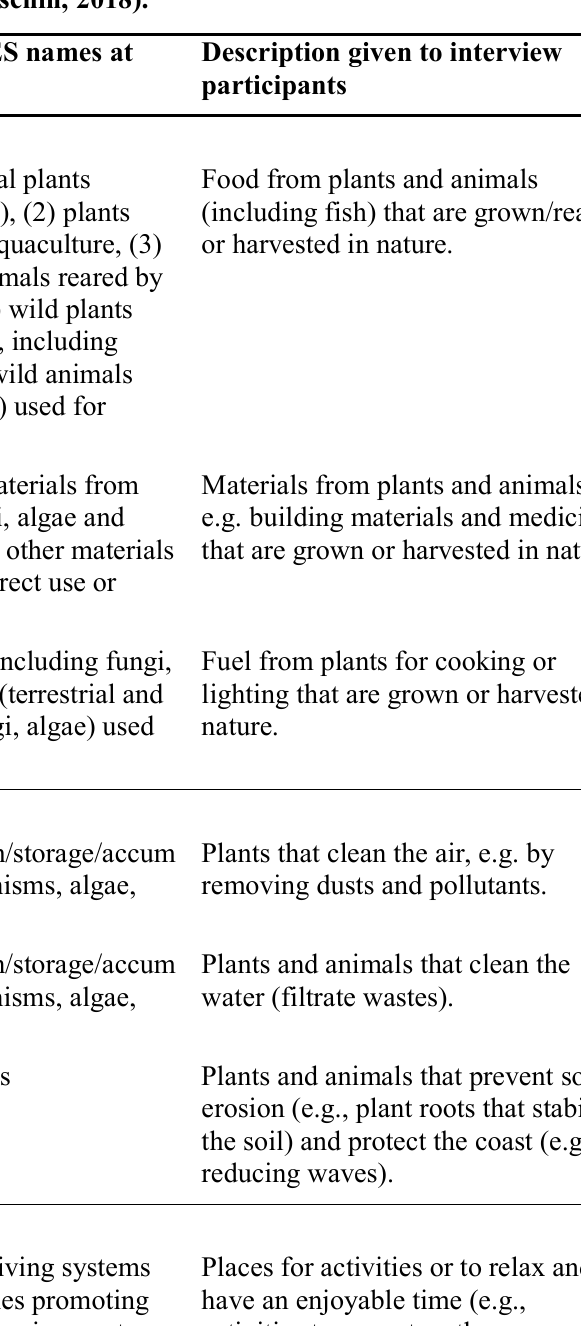
Table A.3. Description of the ecosystem services used in this study and correspondence with CICES (Haines-Young and Potschin,